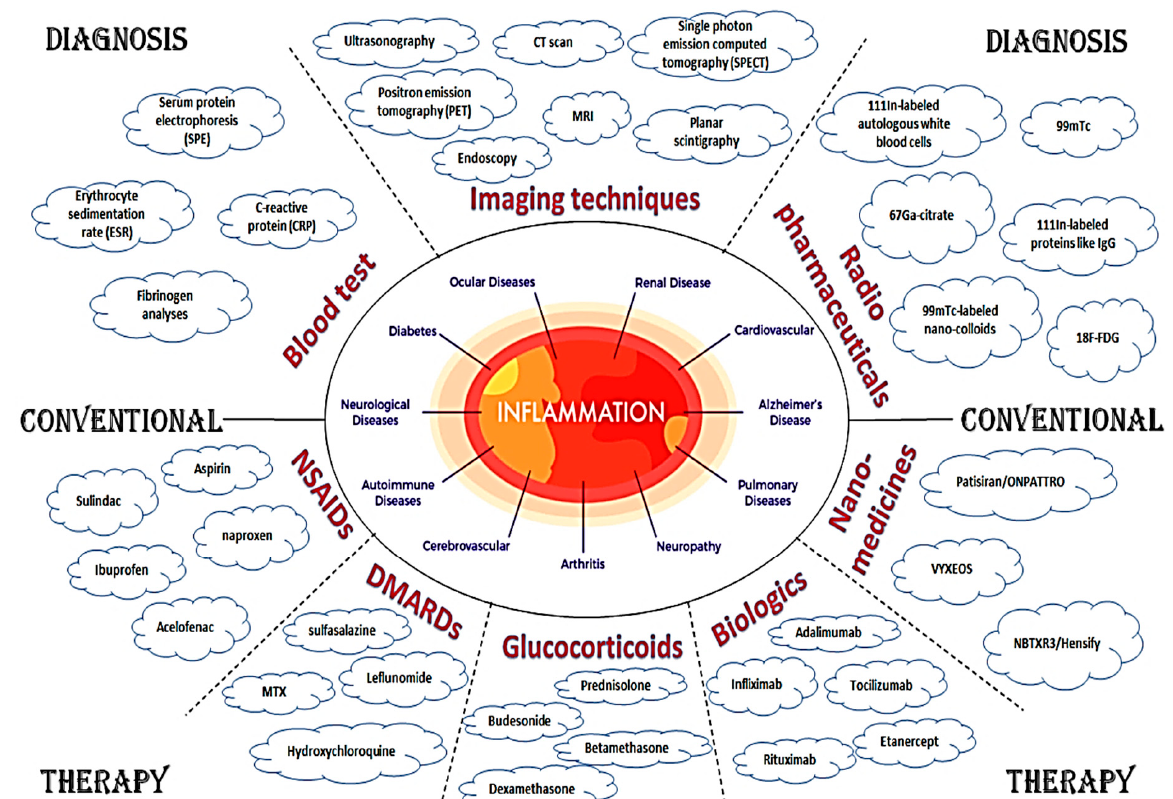
Figure 1. Conventional diagnosis and treatment of in fl ammatory